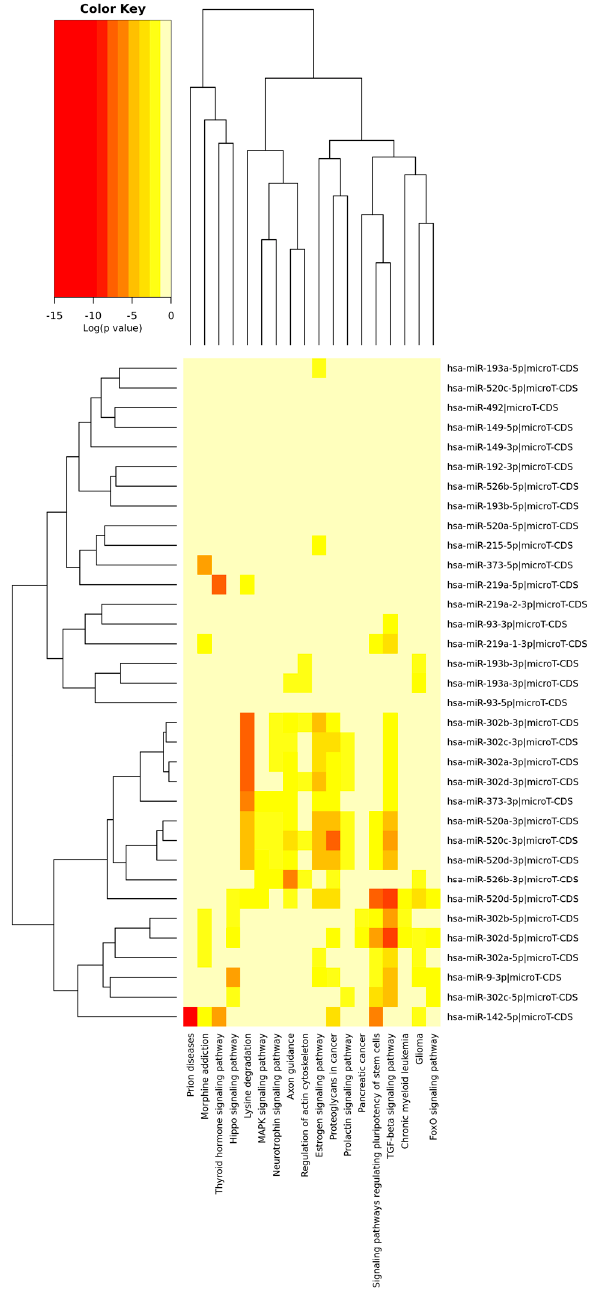
Figure 1. Heatmap of significant predicted downregulated miRNAs (both 5’ and 3’ arm) and relative KEGG activated pathways. The color in the heatmap represents the significance levels ( p -values) between each miRNA and every pathway. A merged p -value is extracted by combining the previously calculated significance levels, using Fisher’s meta-analysis method. Thus, the resulting merged p -values signify if a particular pathway is targeted by at least one miRNA out of the initially selected group. T-CDS: microRNA target coding sequences; TGF: transforming growth